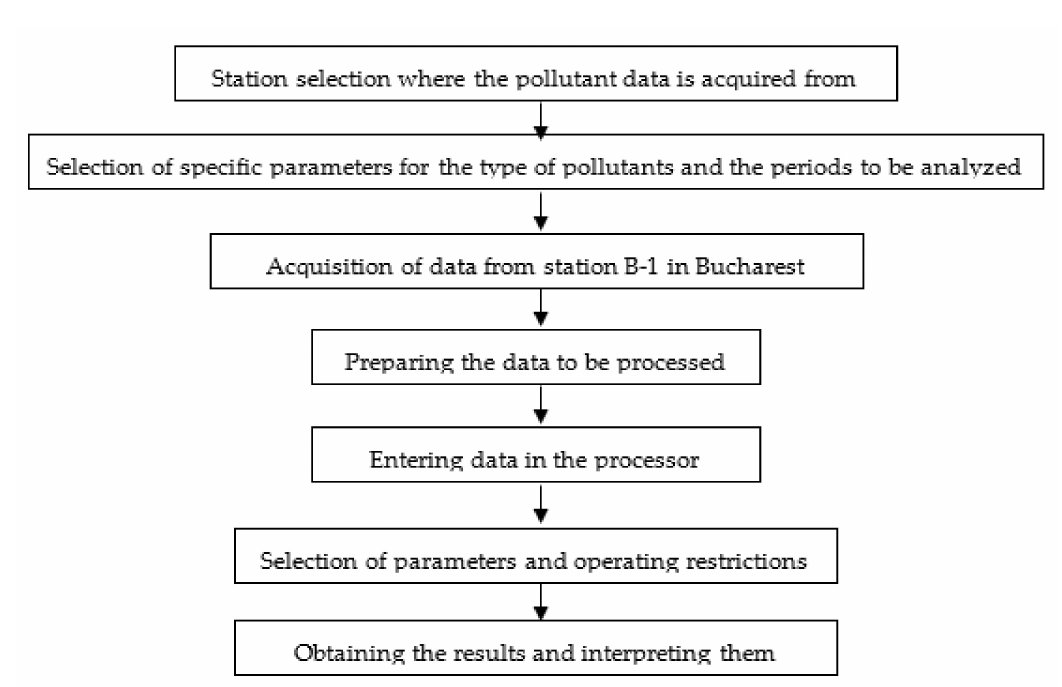
Figure 6. The information flow used to obtain results using machine